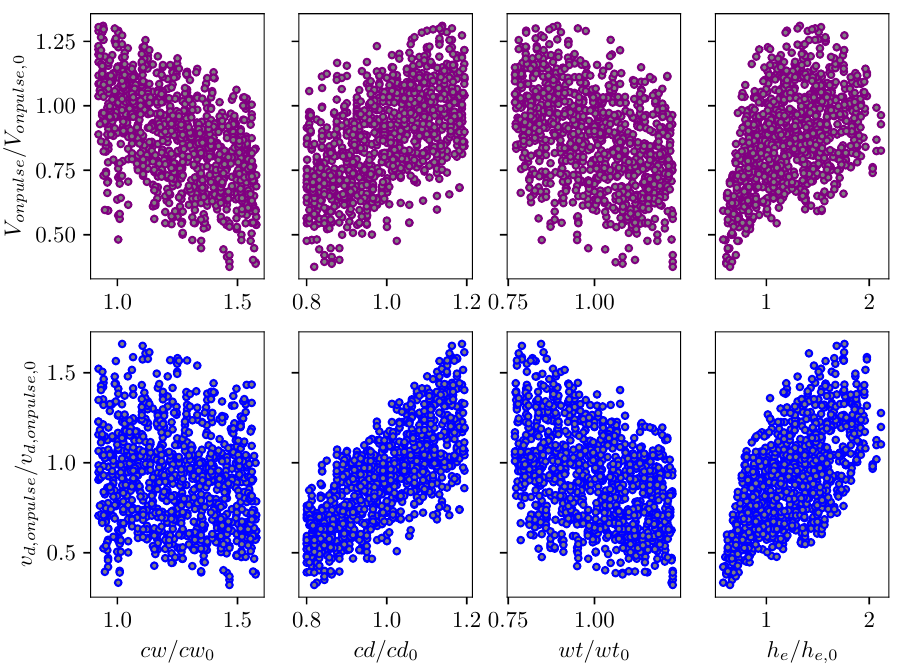
Figure 23. Scatter plot of normalized droplet volume and velocity with changes in inkjet channel geometrical parameters.